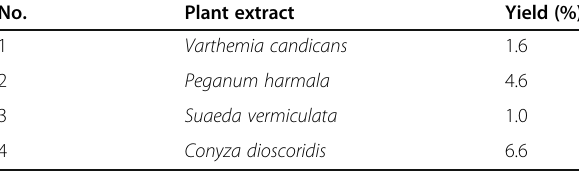
Table 2 Extraction yield of plant extract in aqueous ethanol